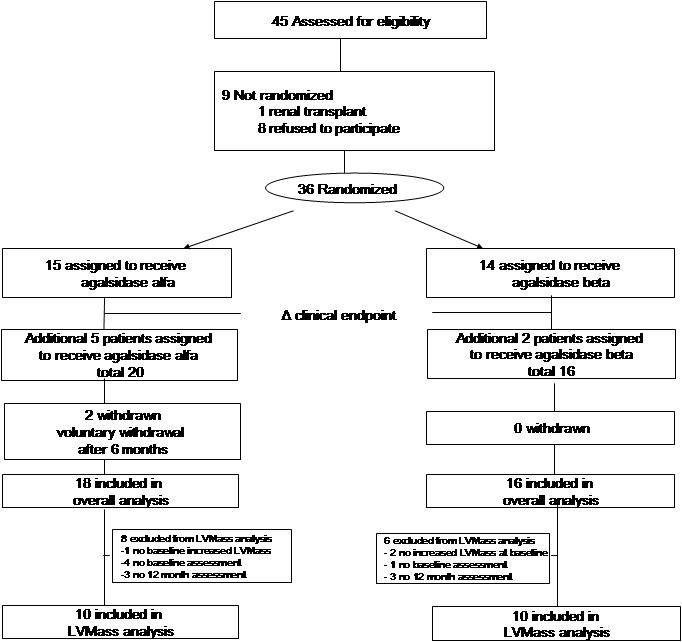
Study flow chart.Δ clinical endpoint: change of primary endpoint from improvement of renal function to reduction in left ventricular mass.